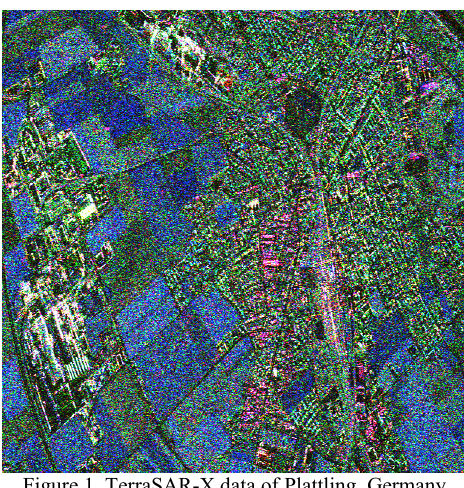
Figure 1. TerraSAR-X data of Plattling, Germany